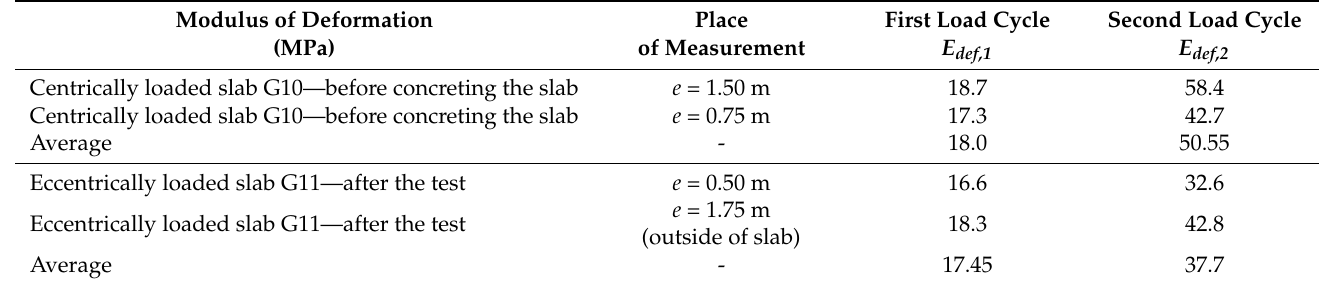
Table 4. Modulus of deformation—subsoil.